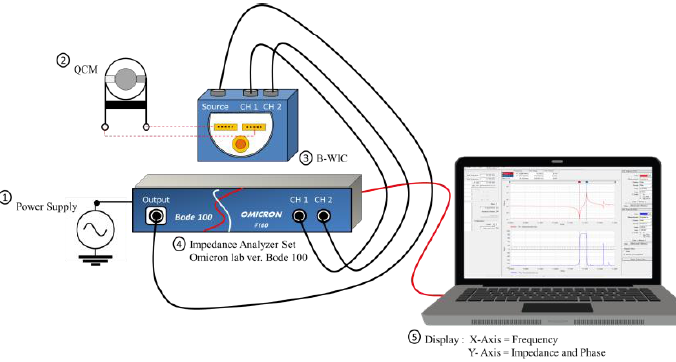
Figure 1. The apparatus for spectroscopic impedance measurements.